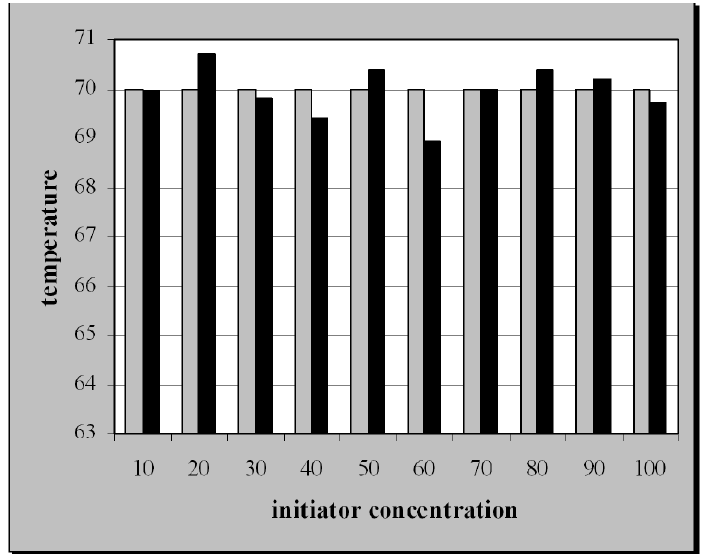
Fig. 21 Temperature values obtained with MLP (2:12:4:2) in INN modeling for a simulated temperature of 70 o C, at di¬erent initiator concentration, I 0 = 10 ¥ 100 mol/m 3 ; gray bars - simulation training data; black bars - results of the inverse neural model.